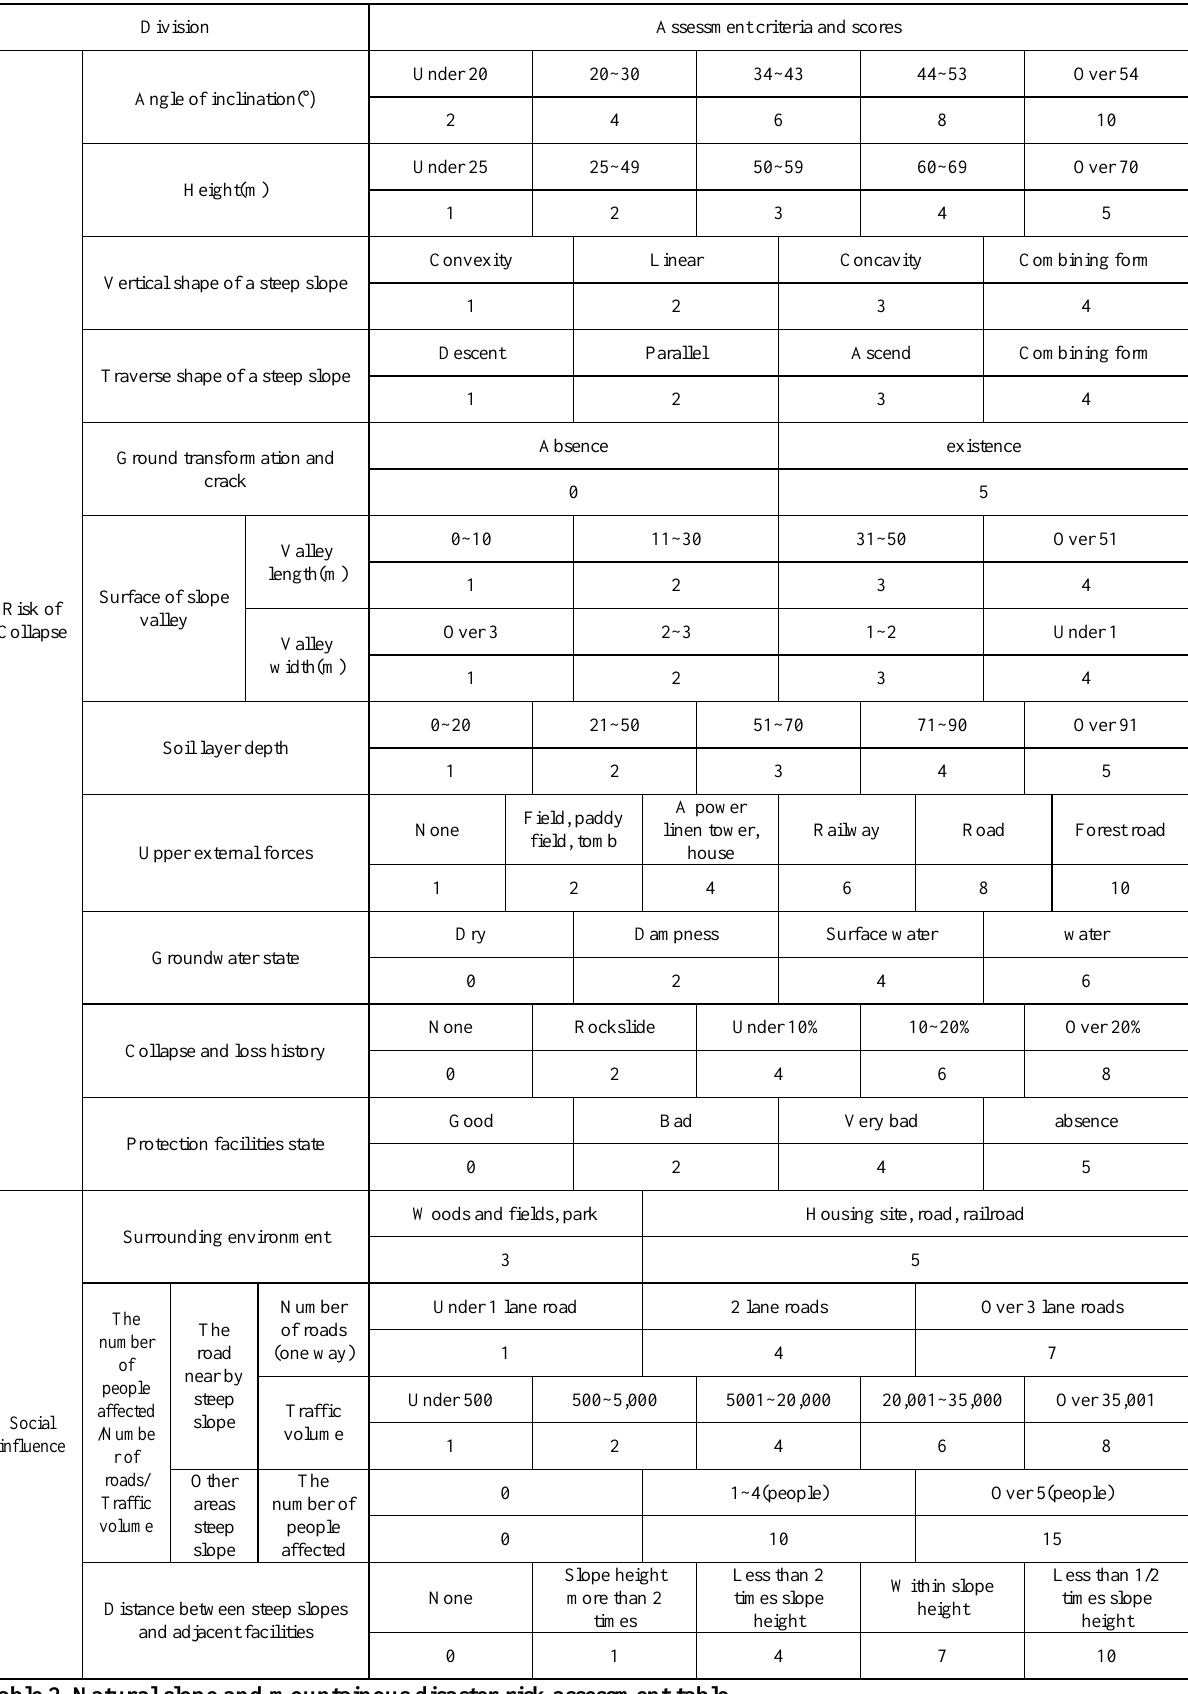
Table 2. Natural slope and mountainous disaster risk assessment